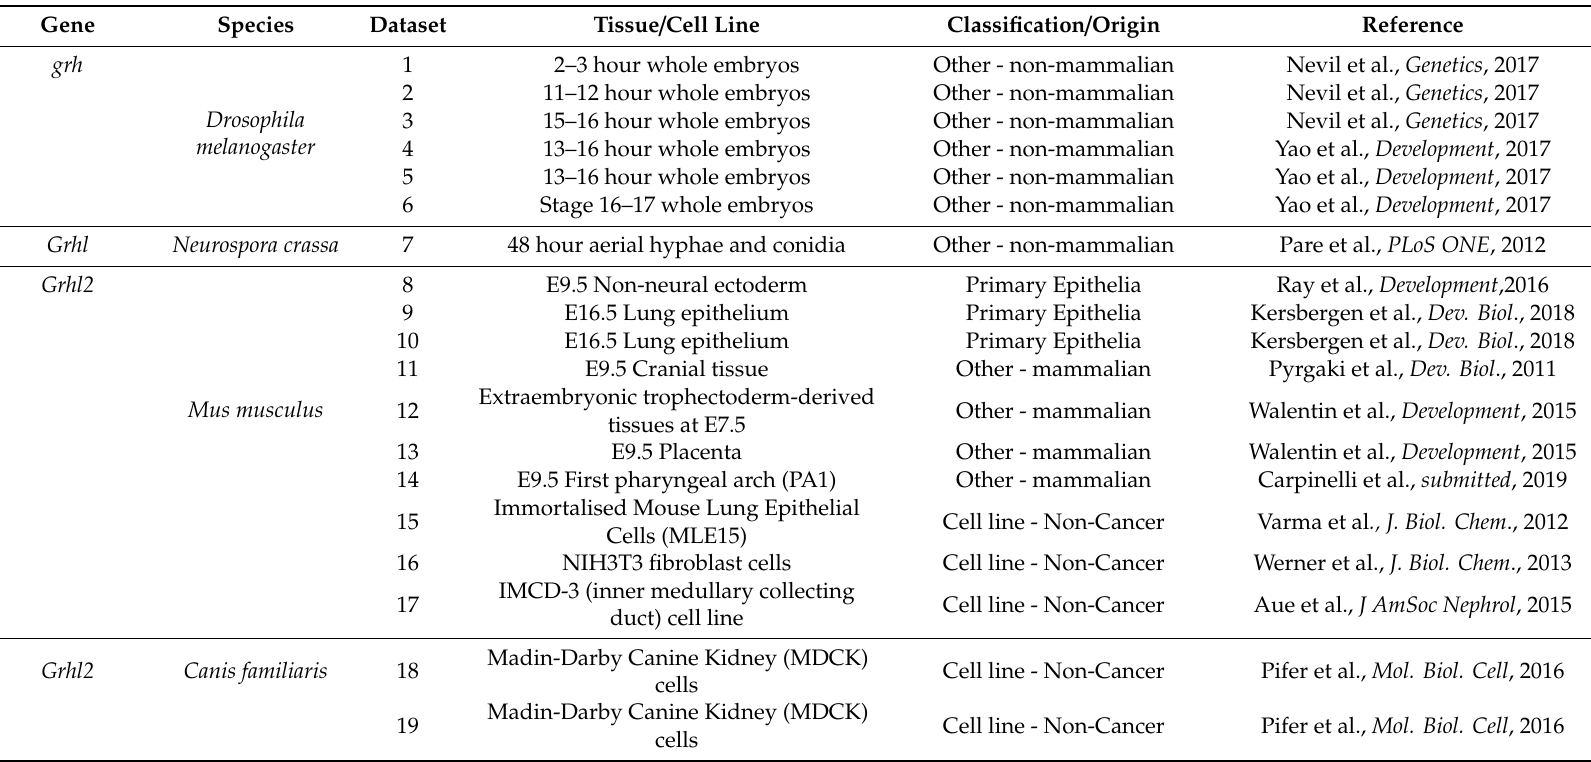
Table 1. Published datasets used for meta-analysis. Microarray and RNA-SEQ datasets including tissue of origin were classified as being derived from either “primary epithelia”, “cell line—cancer”, “cell line—non-cancer”, “other mammalian” or “other non-mammalian”, for subsequent